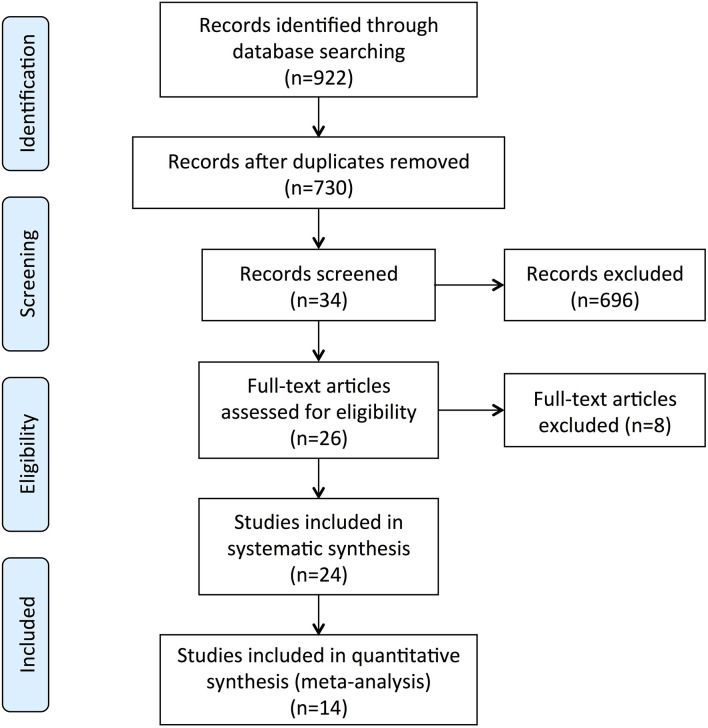
Flow diagram of the assessment of studies identified in this meta-analysis.